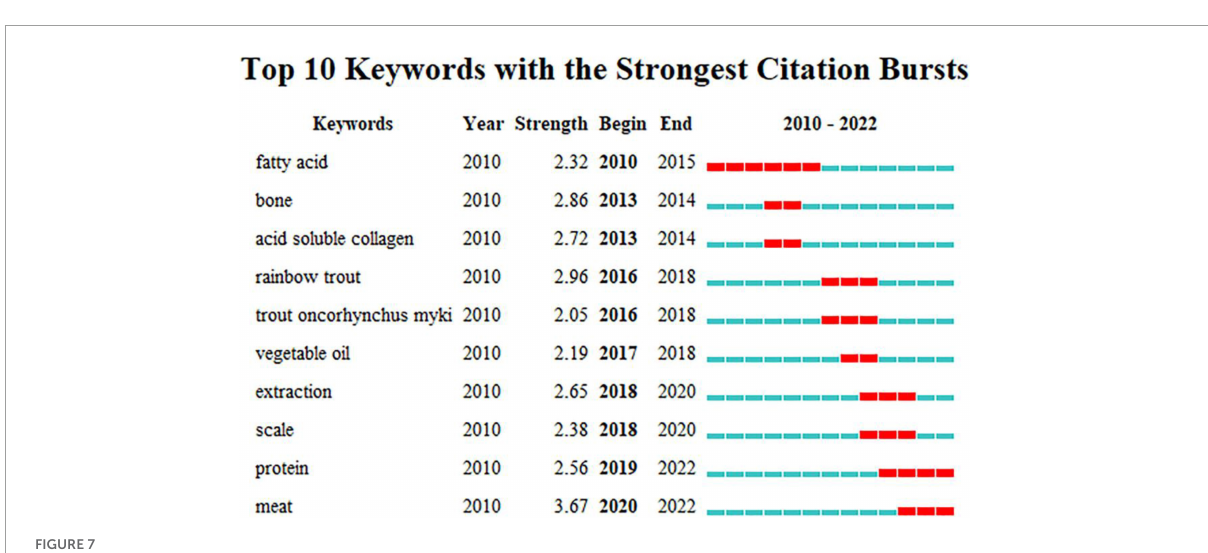
FIGURE7 Keyword emergence